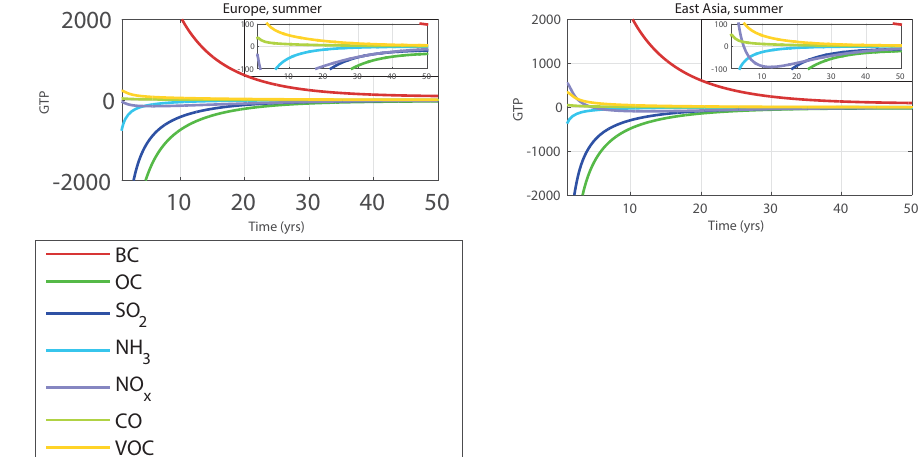
Figure 6. A comparison of GTP values, as a function of time horizon, for summer emissions in Europe (left) and East Asia (right).